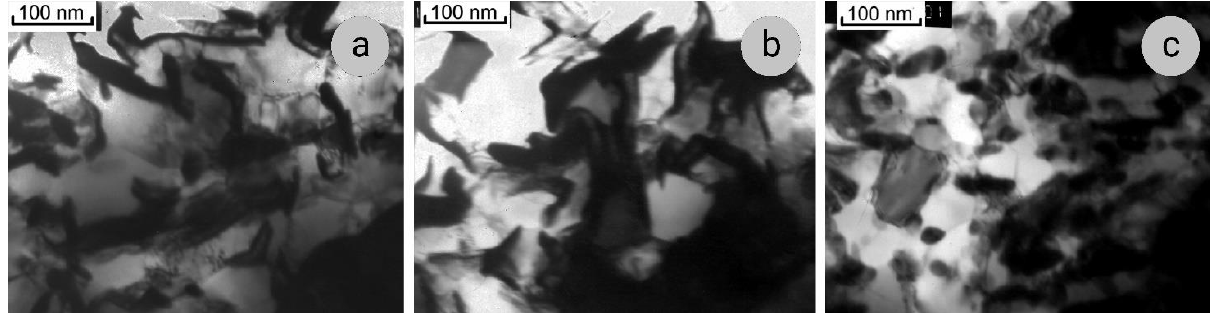
Figure 6. SEM images of Sample 2 ( e = 12.5) after the annealing at 800 ° С, 1 h: ( a ) — transverse section; ( b , с ) — longitudinal sections.